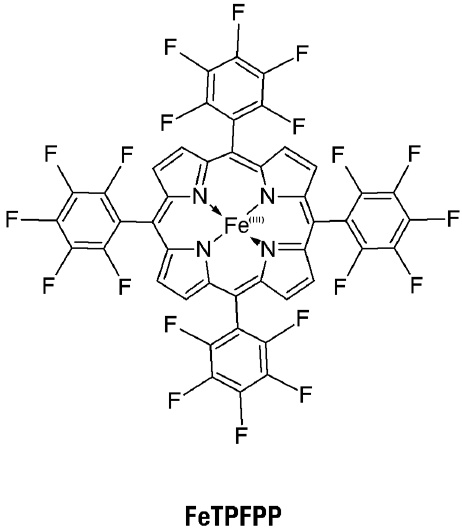
Figure 4. Metalloporphyrin 5,10,15,20-tetrakis-pentafluorophenyl-porphyrinato-iron III (FeTPFPP) used in this study.